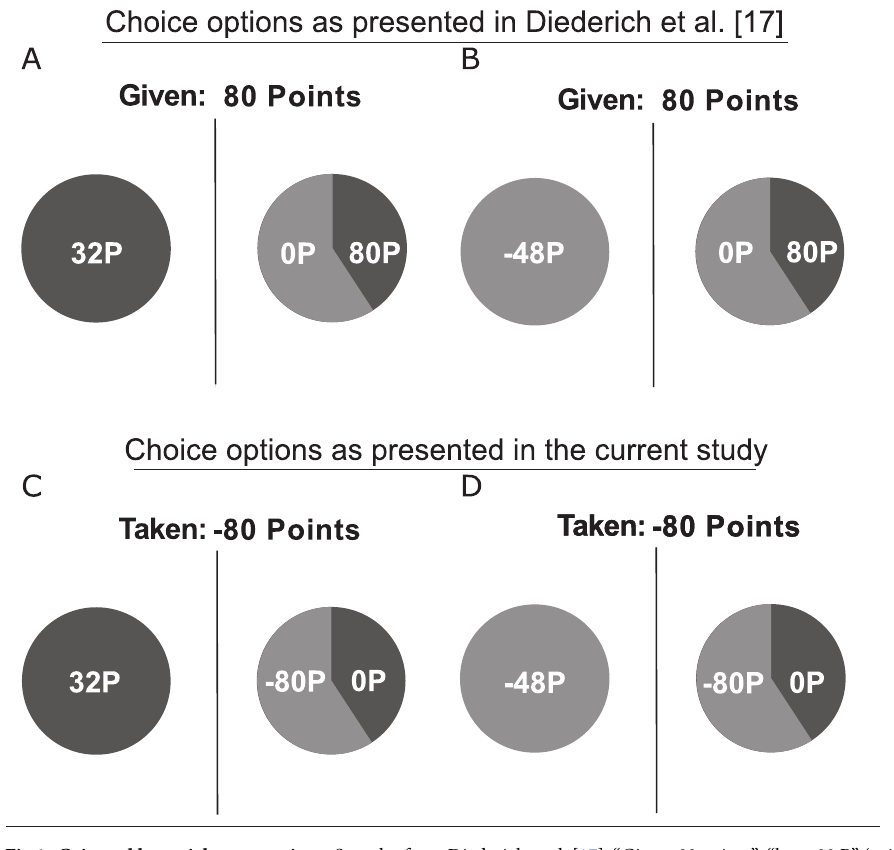
Fig 1. Gain and loss trial presentations. Samples from Diederich et al. [17]: “Given: 80 points”, “keep 32 P” (gain- frame, panel A), “lose 48 P” (loss-frame, panel B); and from the current study: “Taken: -80 points”, “keep 32 P” (gain- frame, panel C), “lose only -48 P” (loss-frame, panel